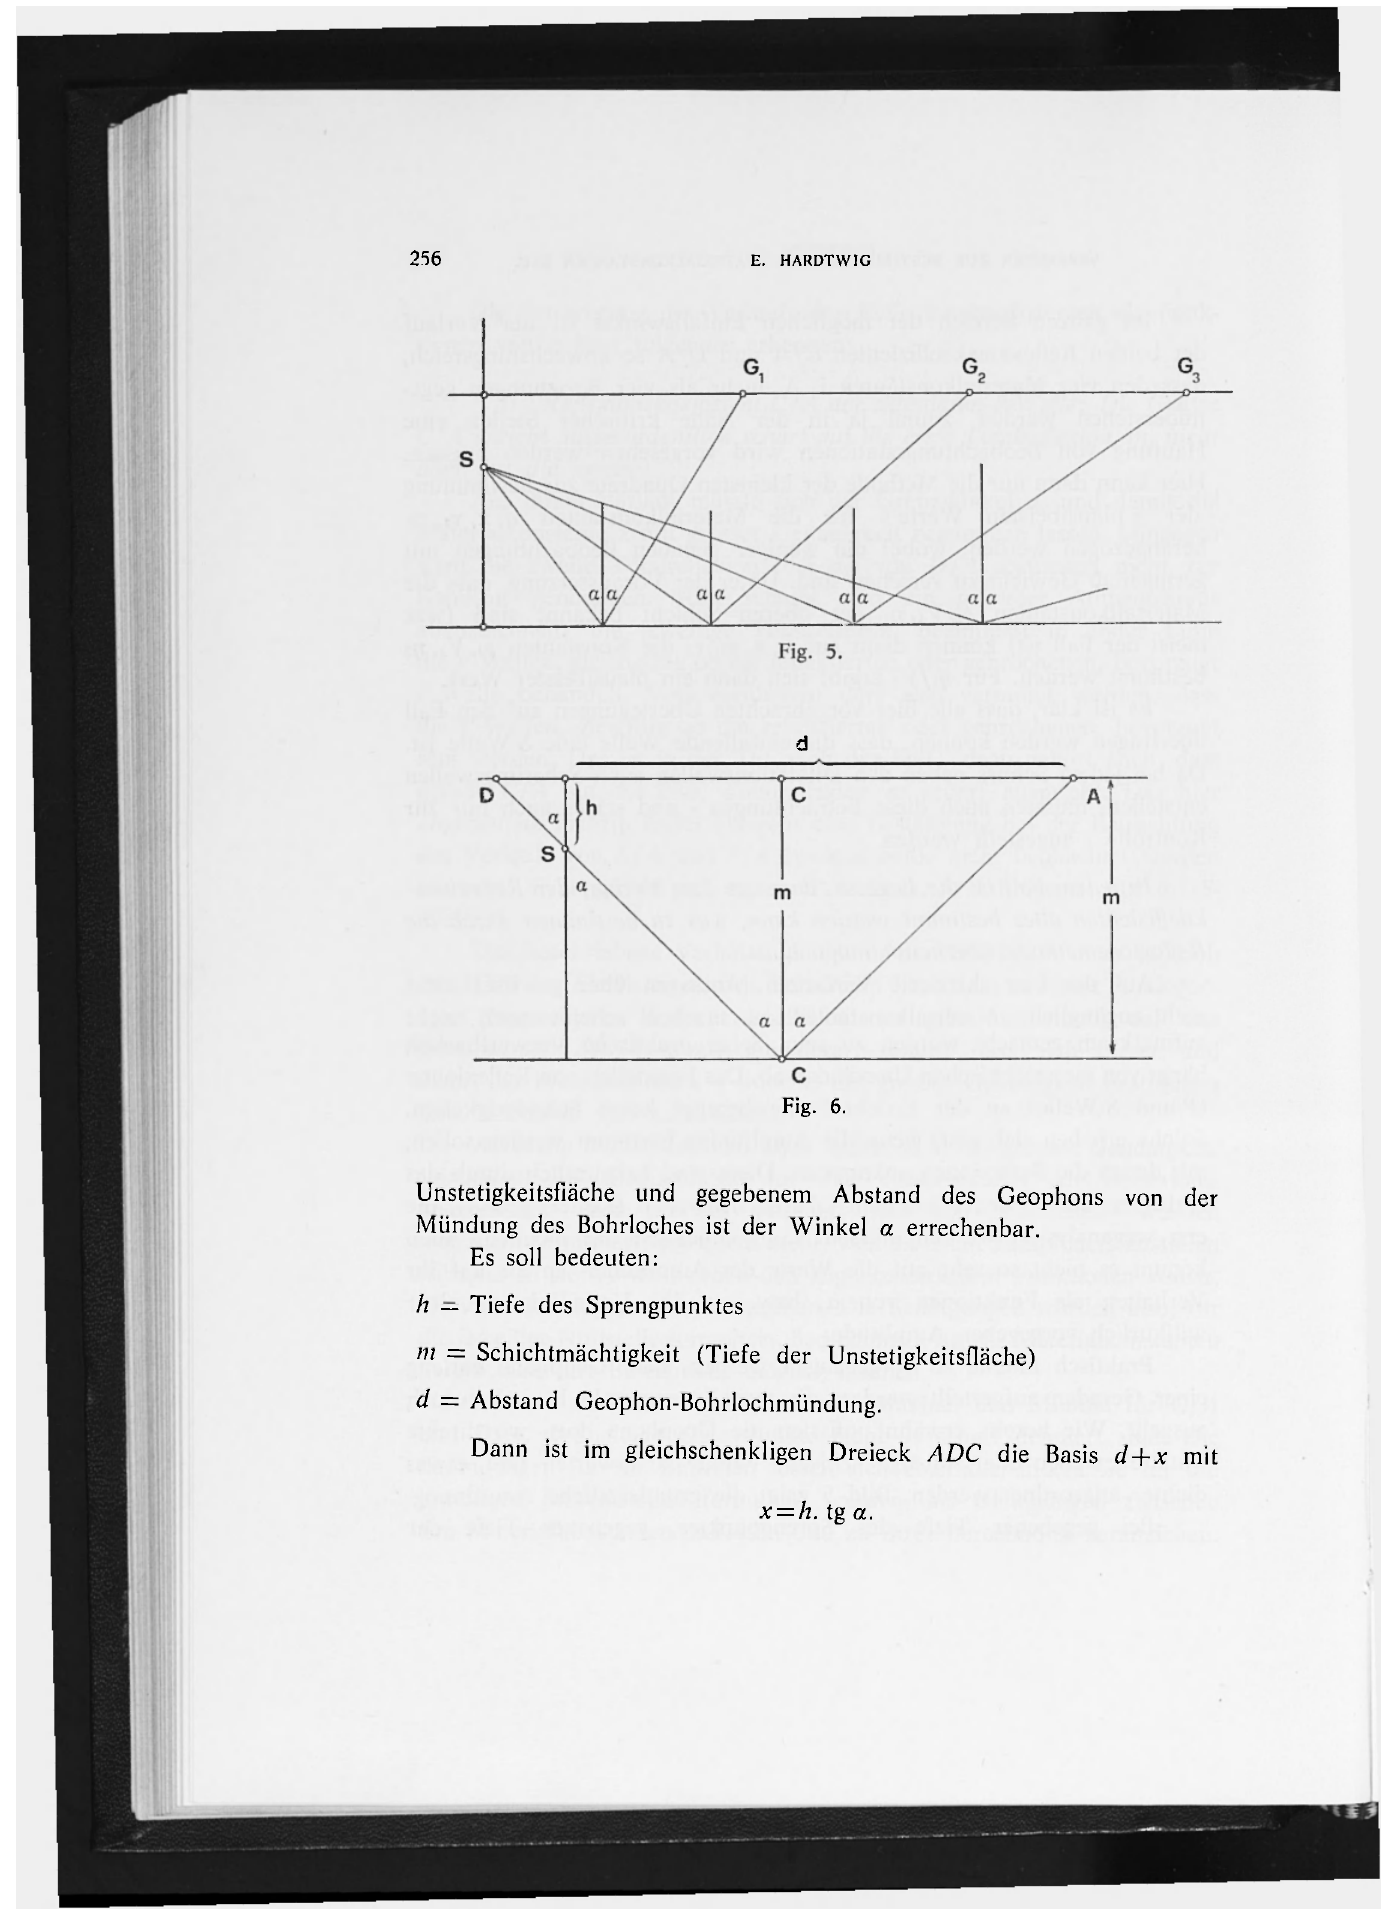
Unstetigkeitsfiäche und gegebenem Abstand des Geophons von